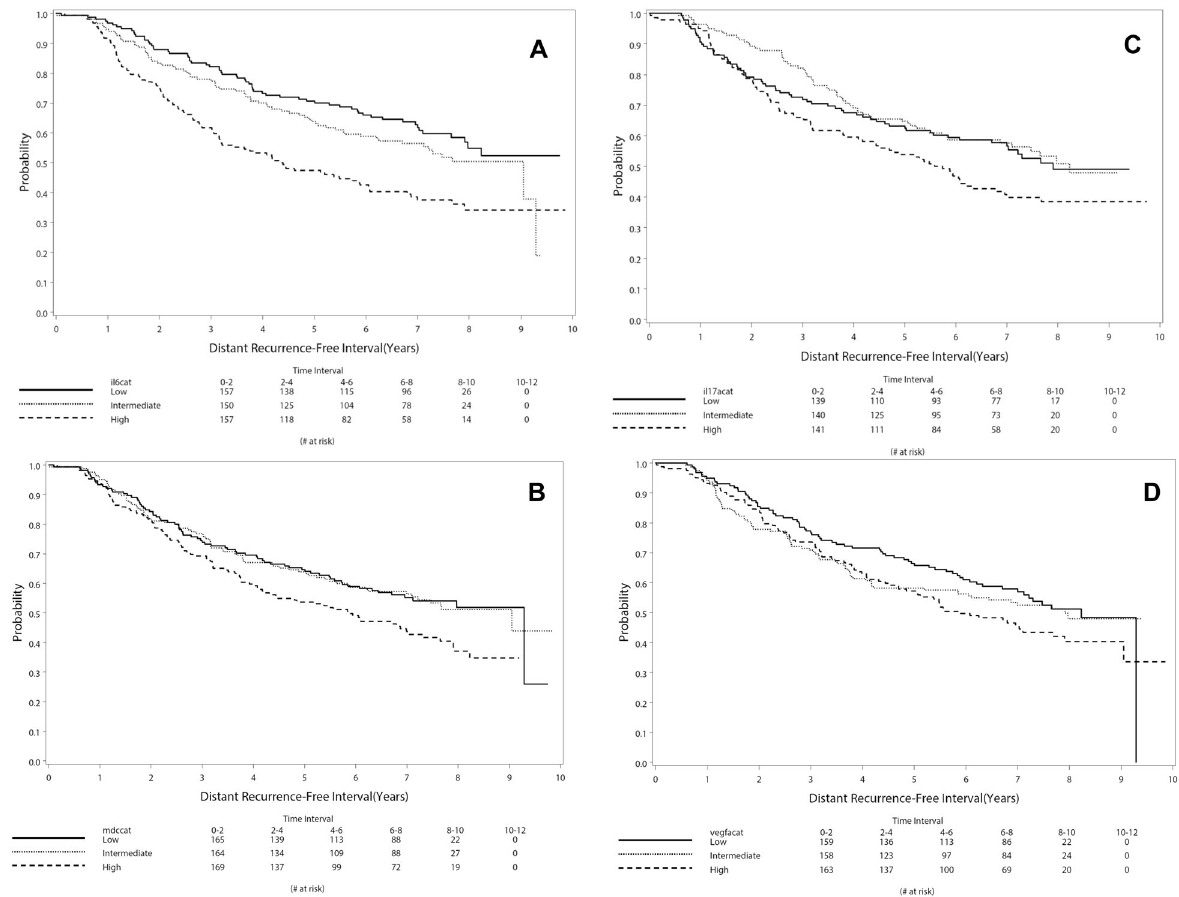
Fig. 2 Time to event by tertile of IL-6, IL-17A, MDC/CCL22, and VEGF-A level. Kaplan – Meier plots of time to distant recurrence for ( A ) IL-6 ( B ), IL-17A, ( C ) MDC/CCL22, and ( D ) VEGF-A. All Kaplan – Meier plots show time to distant recurrence by low ( ≤ 33rd percentile), intermediate (34th – 66th percentile), and high (>66th percentile) biomarker